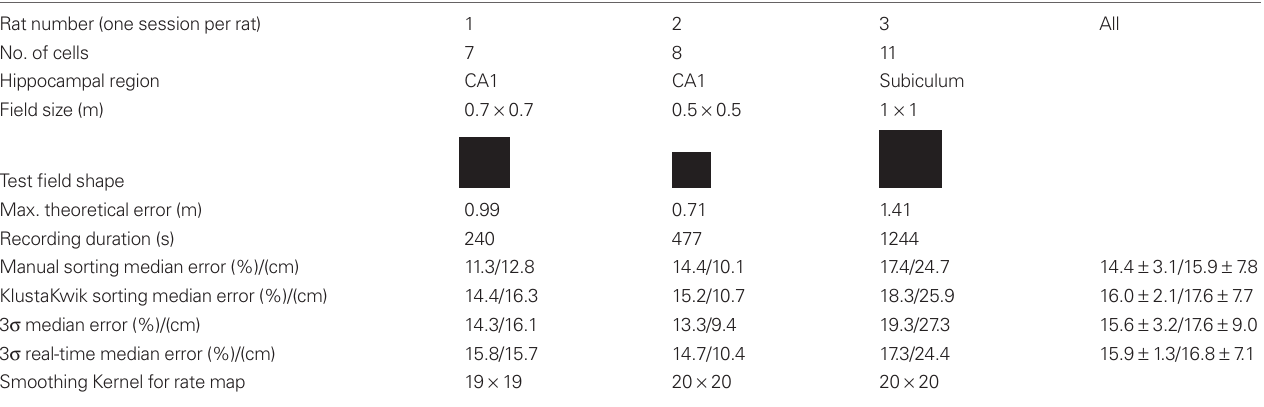
Table 1 | recording information of the off-line experiments (three rats) and off-line position reconstruction error relative to arena diagonal for manual and automatic spike sorting